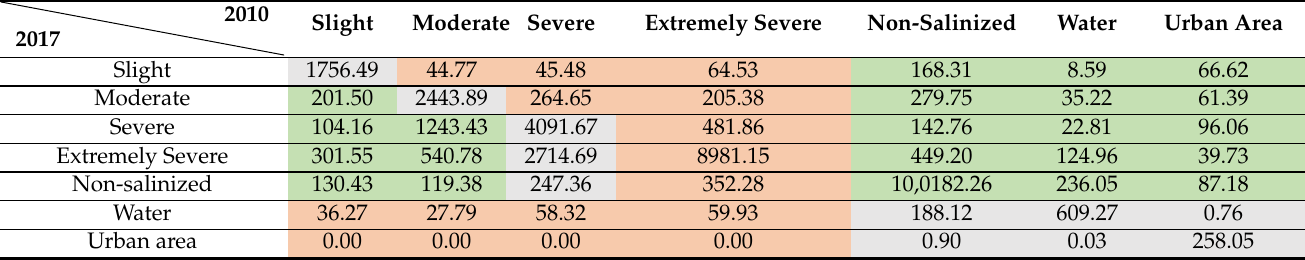
Table 4. Transfer matrix of salinized land from 2010 to 2017 (km 2